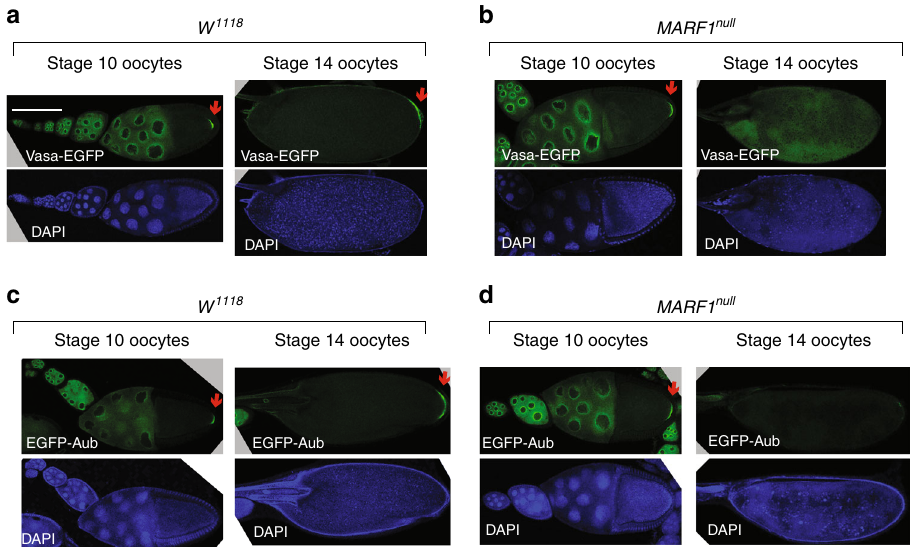
Fig. 4 Loss of germplasm localization of Vasa and Aub in MARF1 null stage 14 oocytes. a Vasa-EGFP localization in control w 1118 stage 10 and stage 14 oocytes. b Vasa-EGFP localization in MARF1 null stage 10 and stage 14 oocytes. c EGFP-Aubergine localization in control w 1118 stage 10 and stage 14 oocytes. d EGFP-Aubergine localization in MARF1 null stage 10 and stage 14 oocytes. Scale bar is 100 μ m